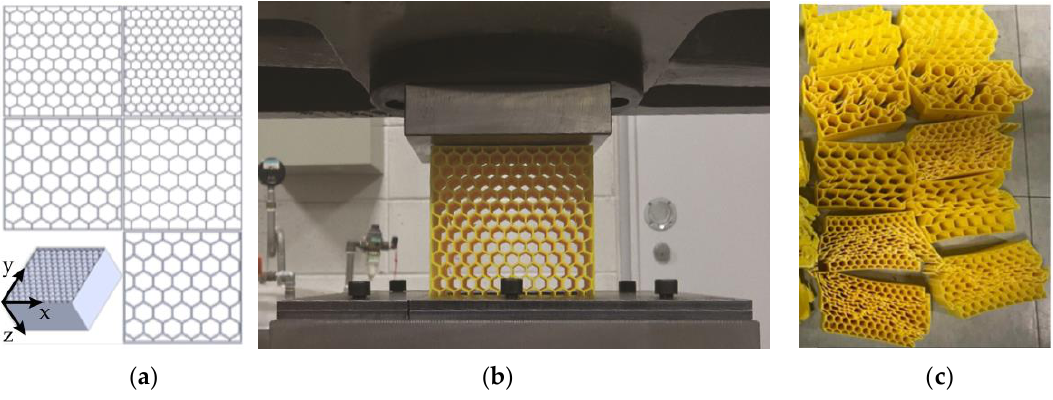
Figure 2. Honeycomb Unit Designs and Compressions Tests Pictures: ( a ) Honeycomb modeling; ( b ) In-plane direction compression test; ( c ) Compressed specimen showing results.